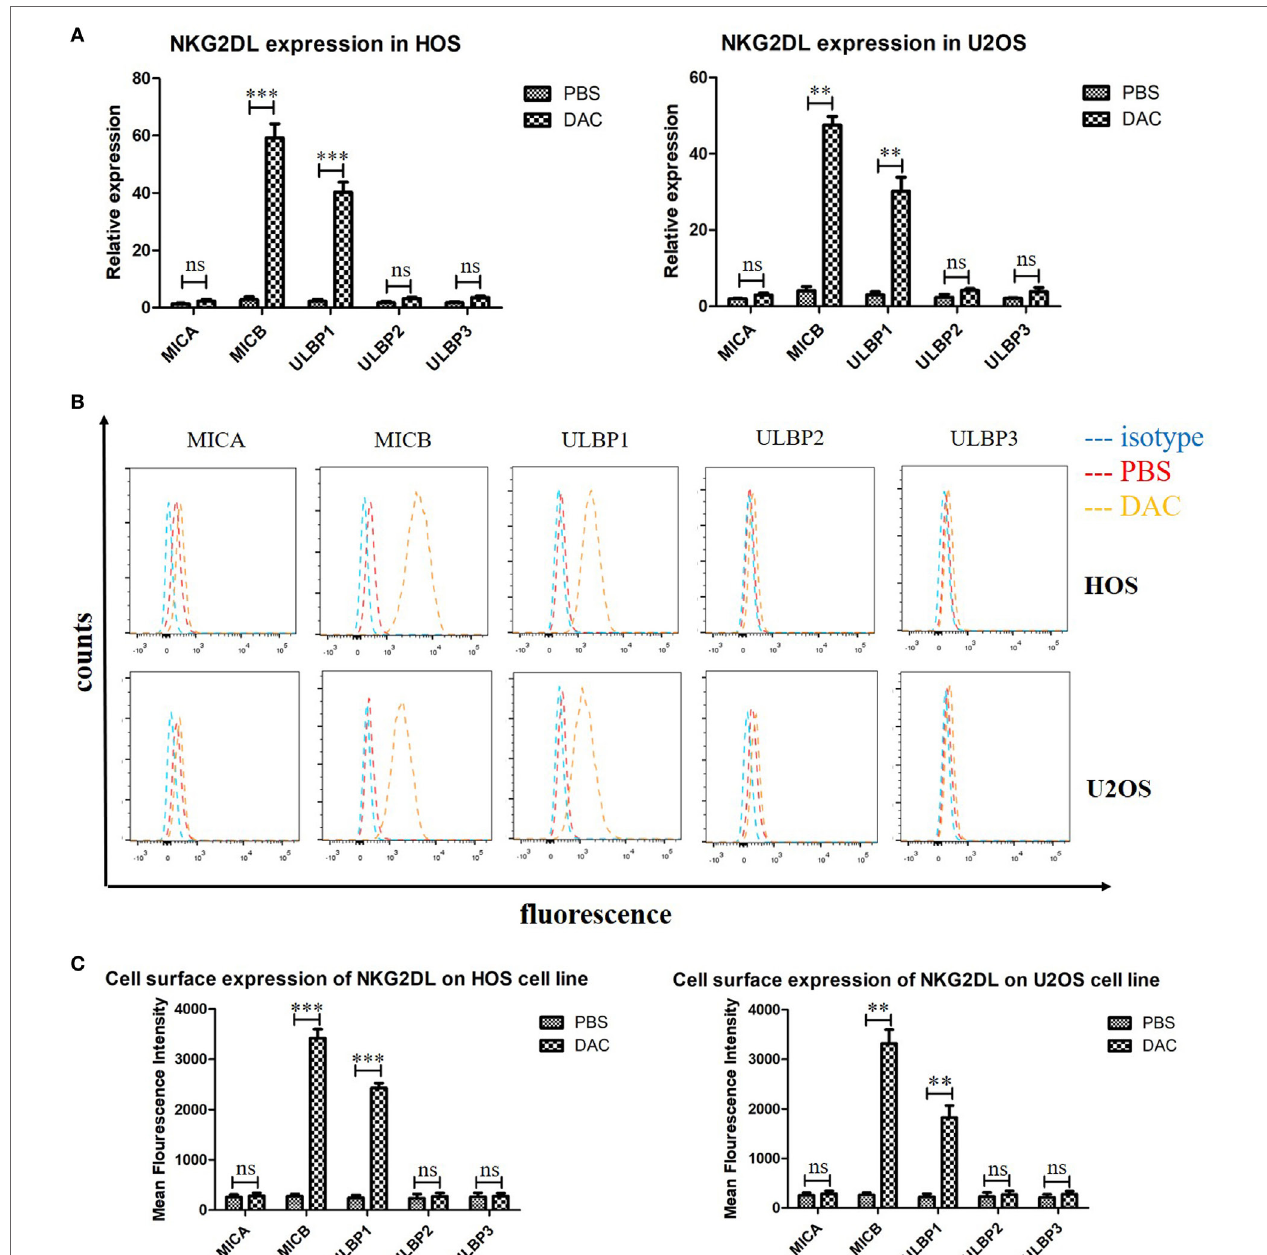
FigUre 3 | Increased expression of MICB and UL16-binding protein 1 (ULBP1) on osteosarcoma (OS) cells after 5 µM decitabine (DAC) treatment for 3 days. (a) NKG2DLs expression of HOS and U2OS cell lines were analyzed by reverse transcription-polymerase chain reaction. Expression levels are relative to GAPDH. MICB and ULBP1 expression was significantly increased after DAC treatment. While the rest NKG2DLs represented no obvious enhanced expression after DAC treatment. (B,c) Cell-surface expression of NKG2DL in OS cells was measured by flow cytometry and quantified by mean fluorescence intensity. The results were in line with PCR results. For (a,c) , samples were run in triplicates. Error bars show standard deviation among the replicates (ns refers to no significance. *** P <